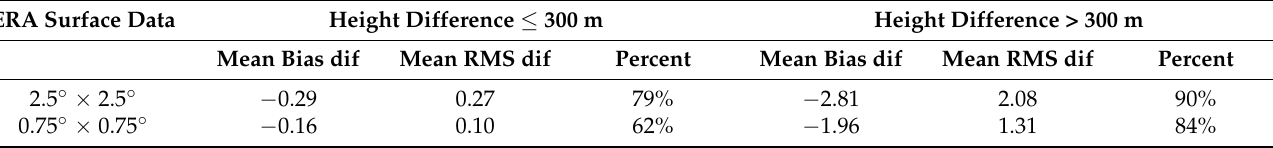
Table 3. Performance comparison of the Berg function and our method for pressure reduction. The bias and RMS differences (in hPa) refer to the results obtained from the Berg function minus those from our method. The percentage of stations at which our method outperforms the Berg function is also